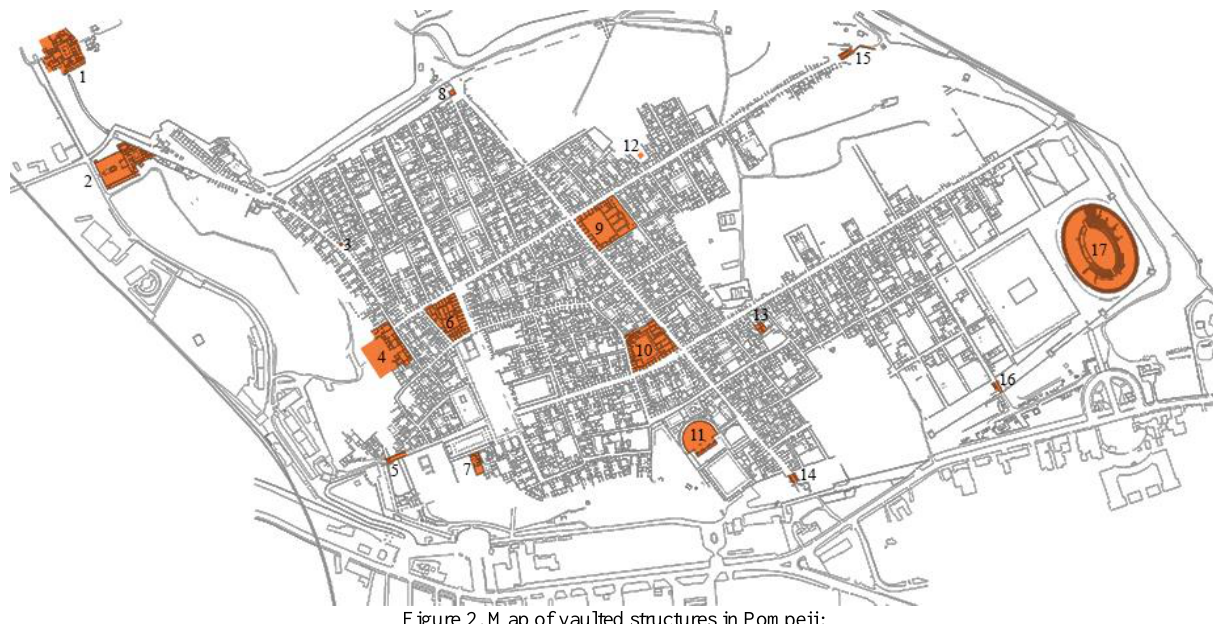
Figure 2. Map of vaulted structures in